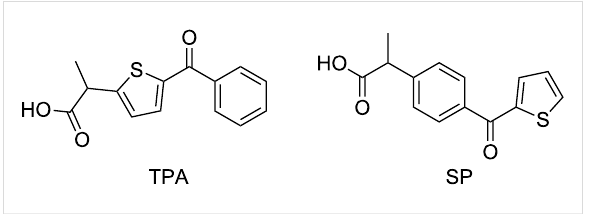
Figure 2: Chemical structure of tiaprofenic acid (TPA) and suprofen